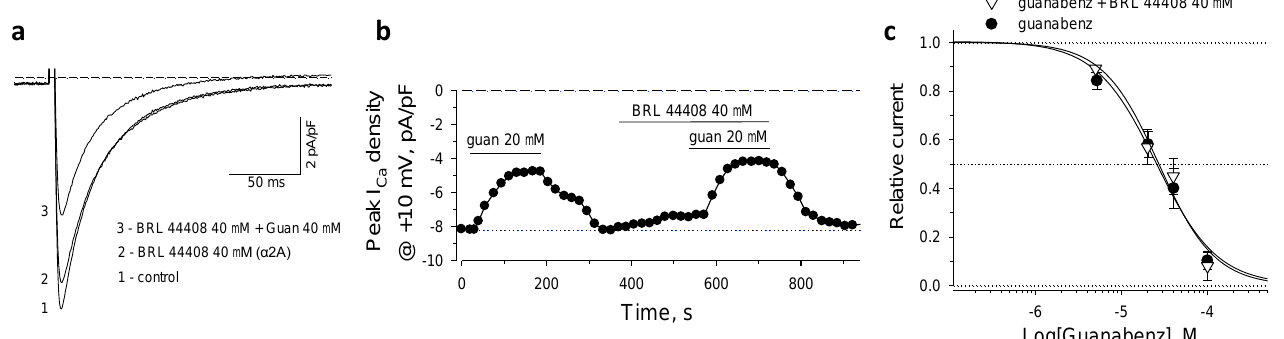
Figure 2. BRL 44408, a specific antagonist of the α 2A isoform, did not affect the guanabenz-induced suppression of I CaL . ( a , b ) Representative I CaL recordings and time-course of peak I CaL density values in the presence of guanabenz (guan) and BRL 44408. Horizontal bars denote the protocol of the drug applications. ( c ) BRL 44408 did not induce a significant rightward shift of dose-dependent inhibition of I CaL by guanabenz. Curves represent the Hill’s fits with parameters indicated in the text.